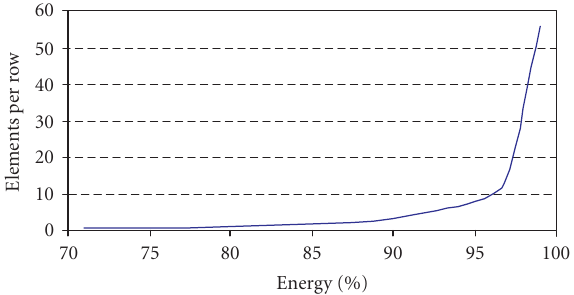
Figure 4: Results from reconstructed images from spiral sampling for image size 128 × 128 showing average number of elements per row for retained energy levels between 70-99%. The number of elements per row increases dramatically after 95% level.